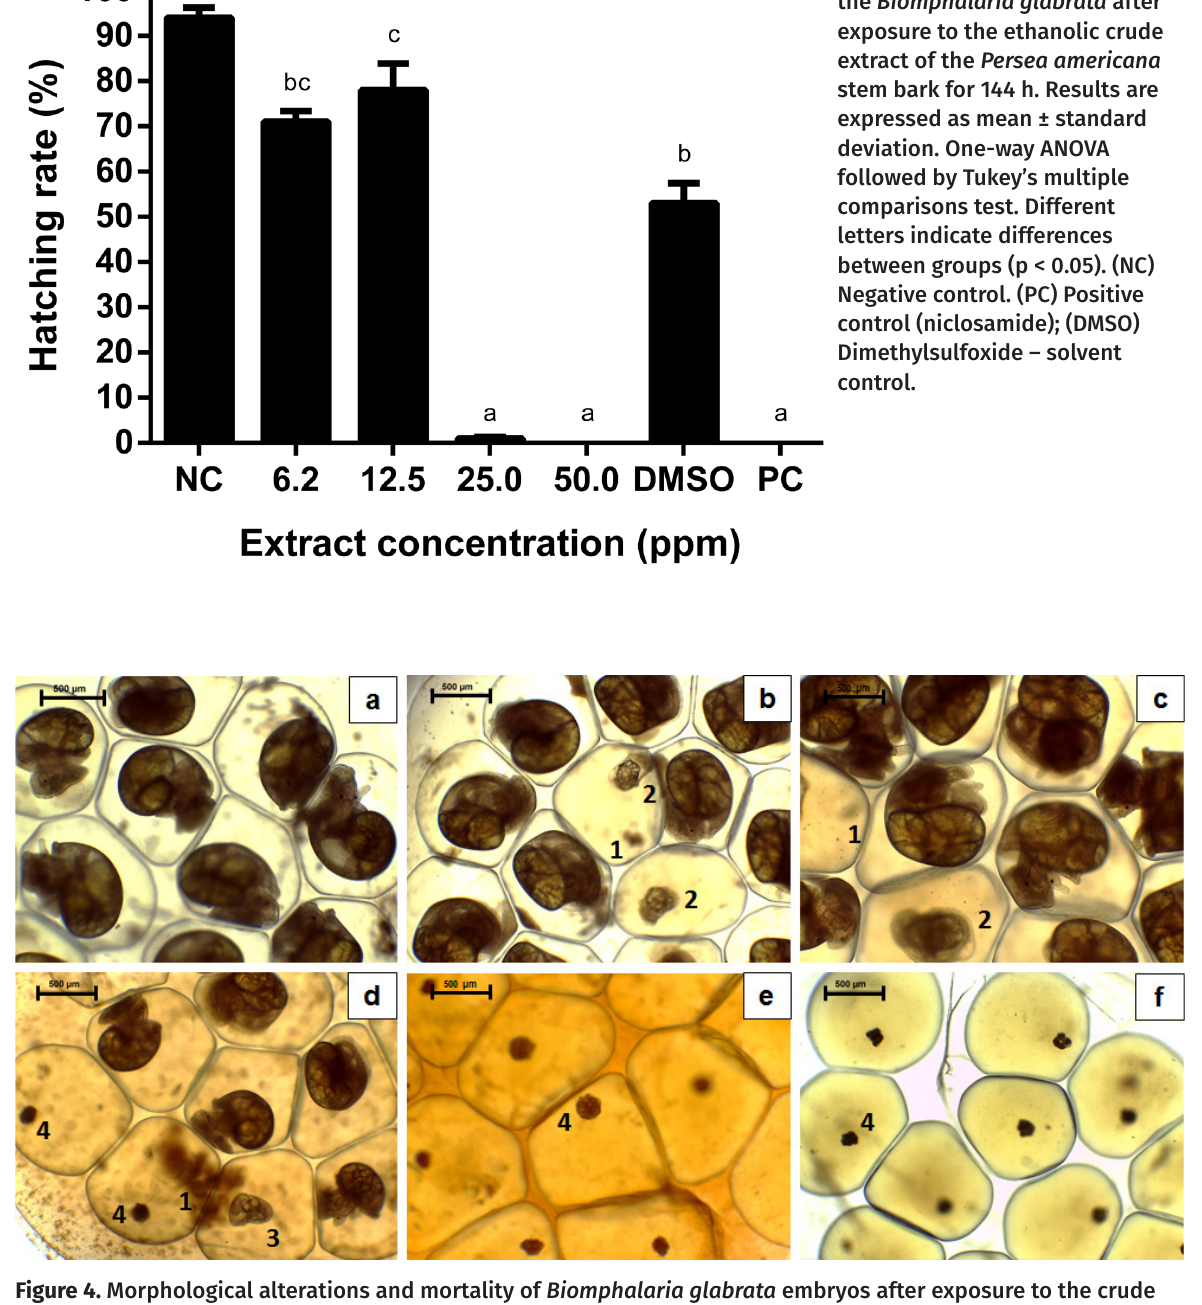
Figure 3. Hatching rate (%) of the Biomphalaria glabrata after extract of the Persea americana